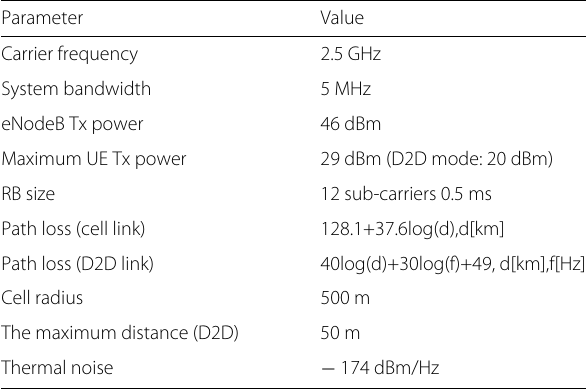
Table 1 Simulation